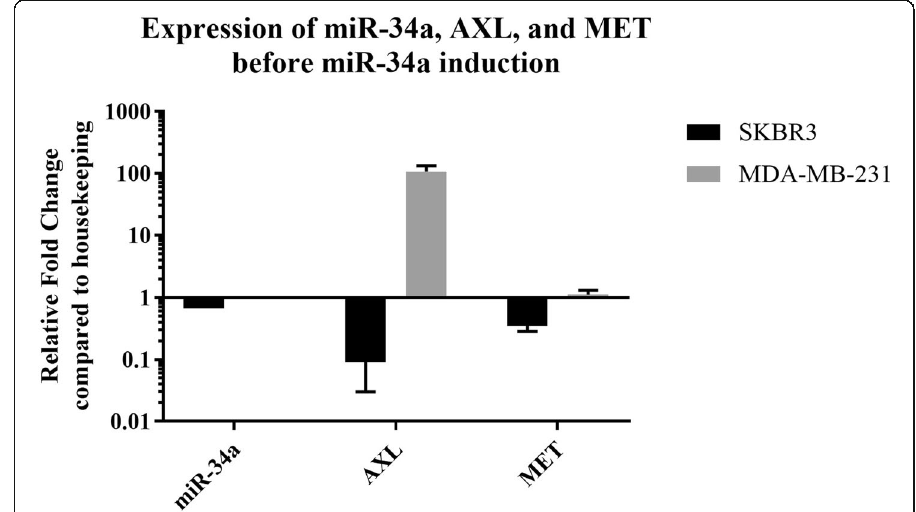
Fig. 2 Expression of miR-34a, AXL , and MET in MDA-MB-231 and SK-BR-3 cell lines before miR-34a